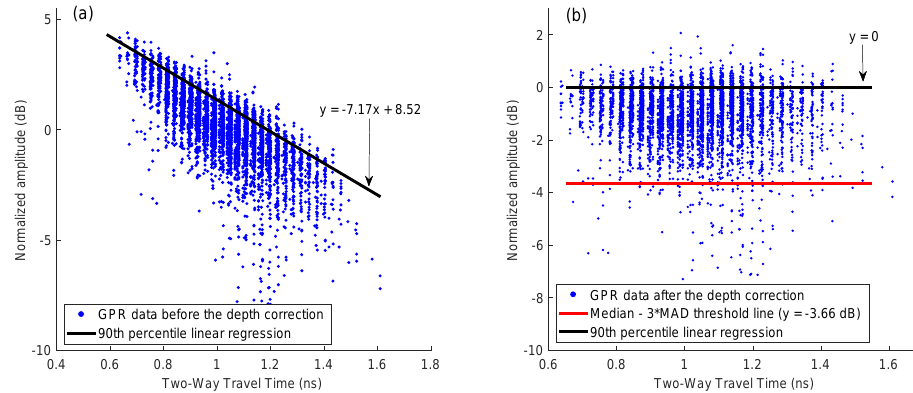
Figure 6. Scatter plot of GPR data points ( a ) before and ( b ) after amplitude-depth correction and 90th percentile linear regression from the bridge with sound